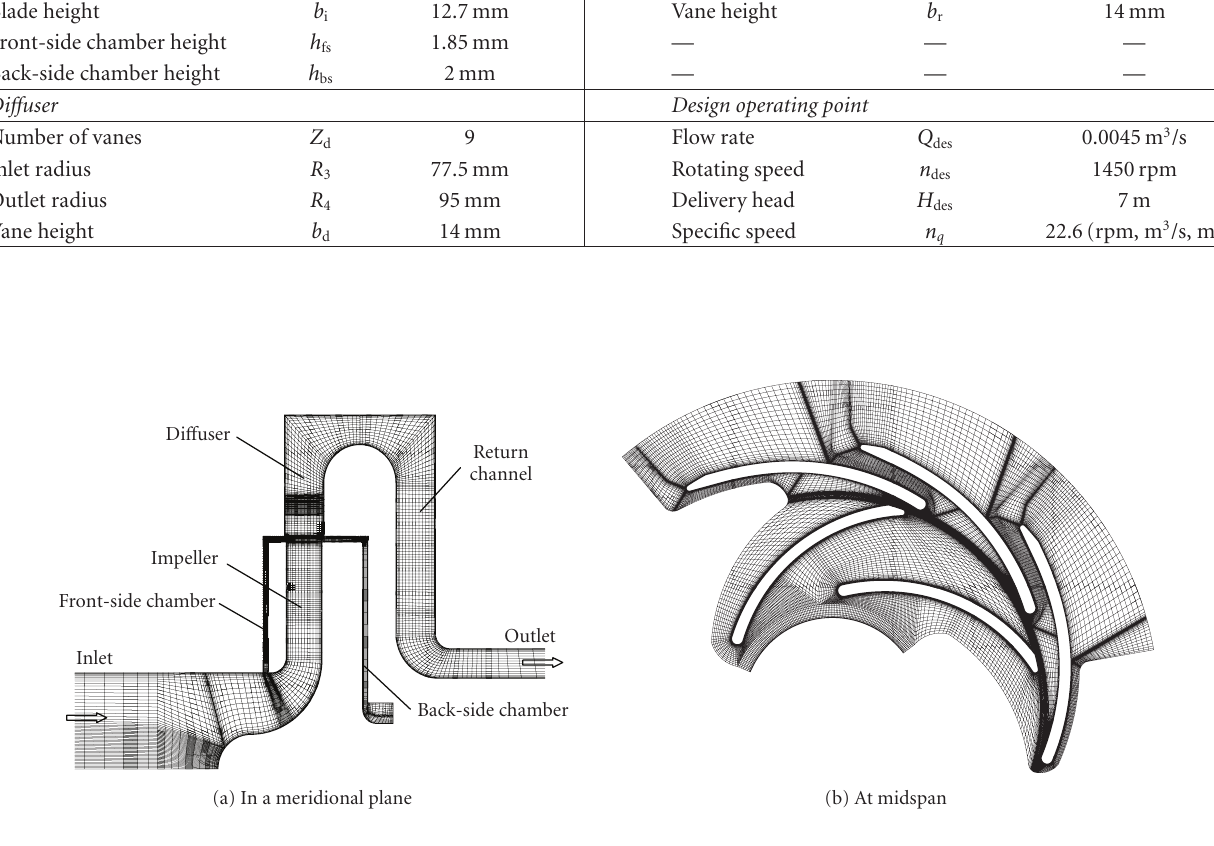
Figure 1: Grid view of the computational